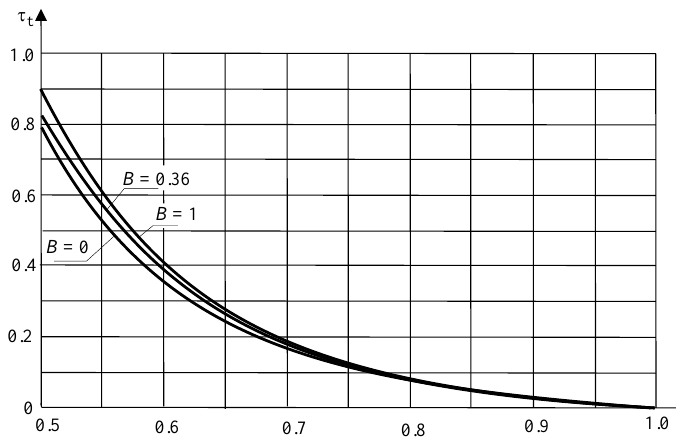
Figure 5. The dependence of the total solidification time on the parameter 𝑠 for various values of 𝐵 ( 𝐵𝑖 𝐶𝑂𝑁 = 10 , 𝐵𝑖 𝐶 = 177 ; in the case of 𝐵 > 0, 𝑆𝑡𝑒 = 0.112 , 𝑎̃ = 0.886 , 𝑘̃ = 1 ).